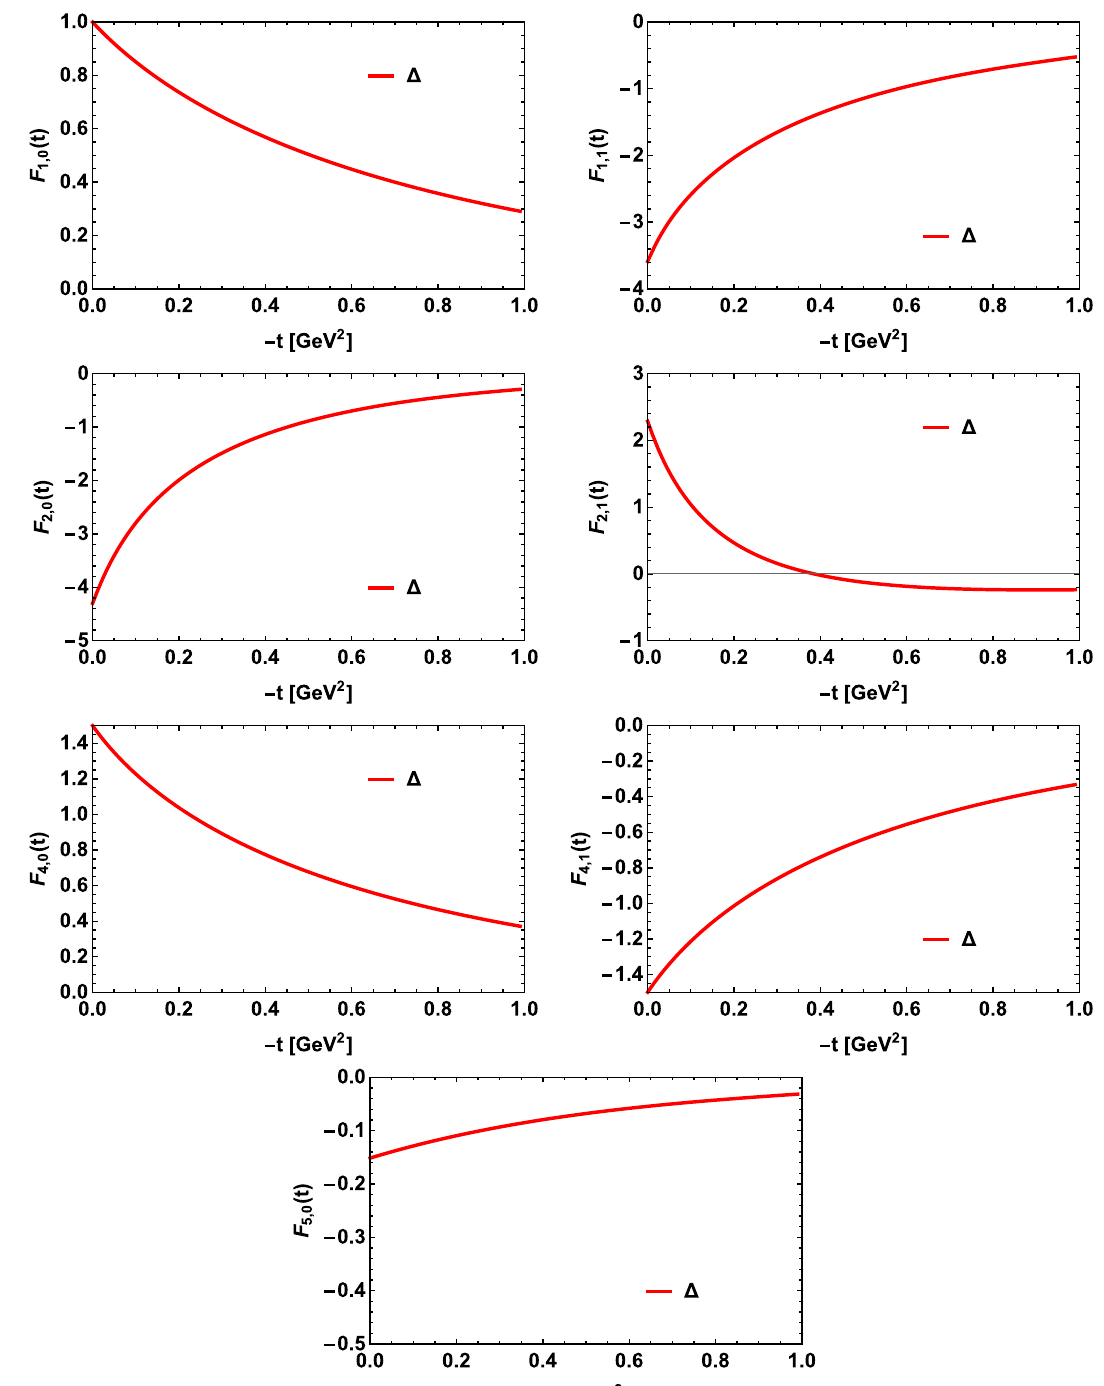
Fig. 7 Gravitational form factors of the (cid:2) as a function of squared momentum transfer t